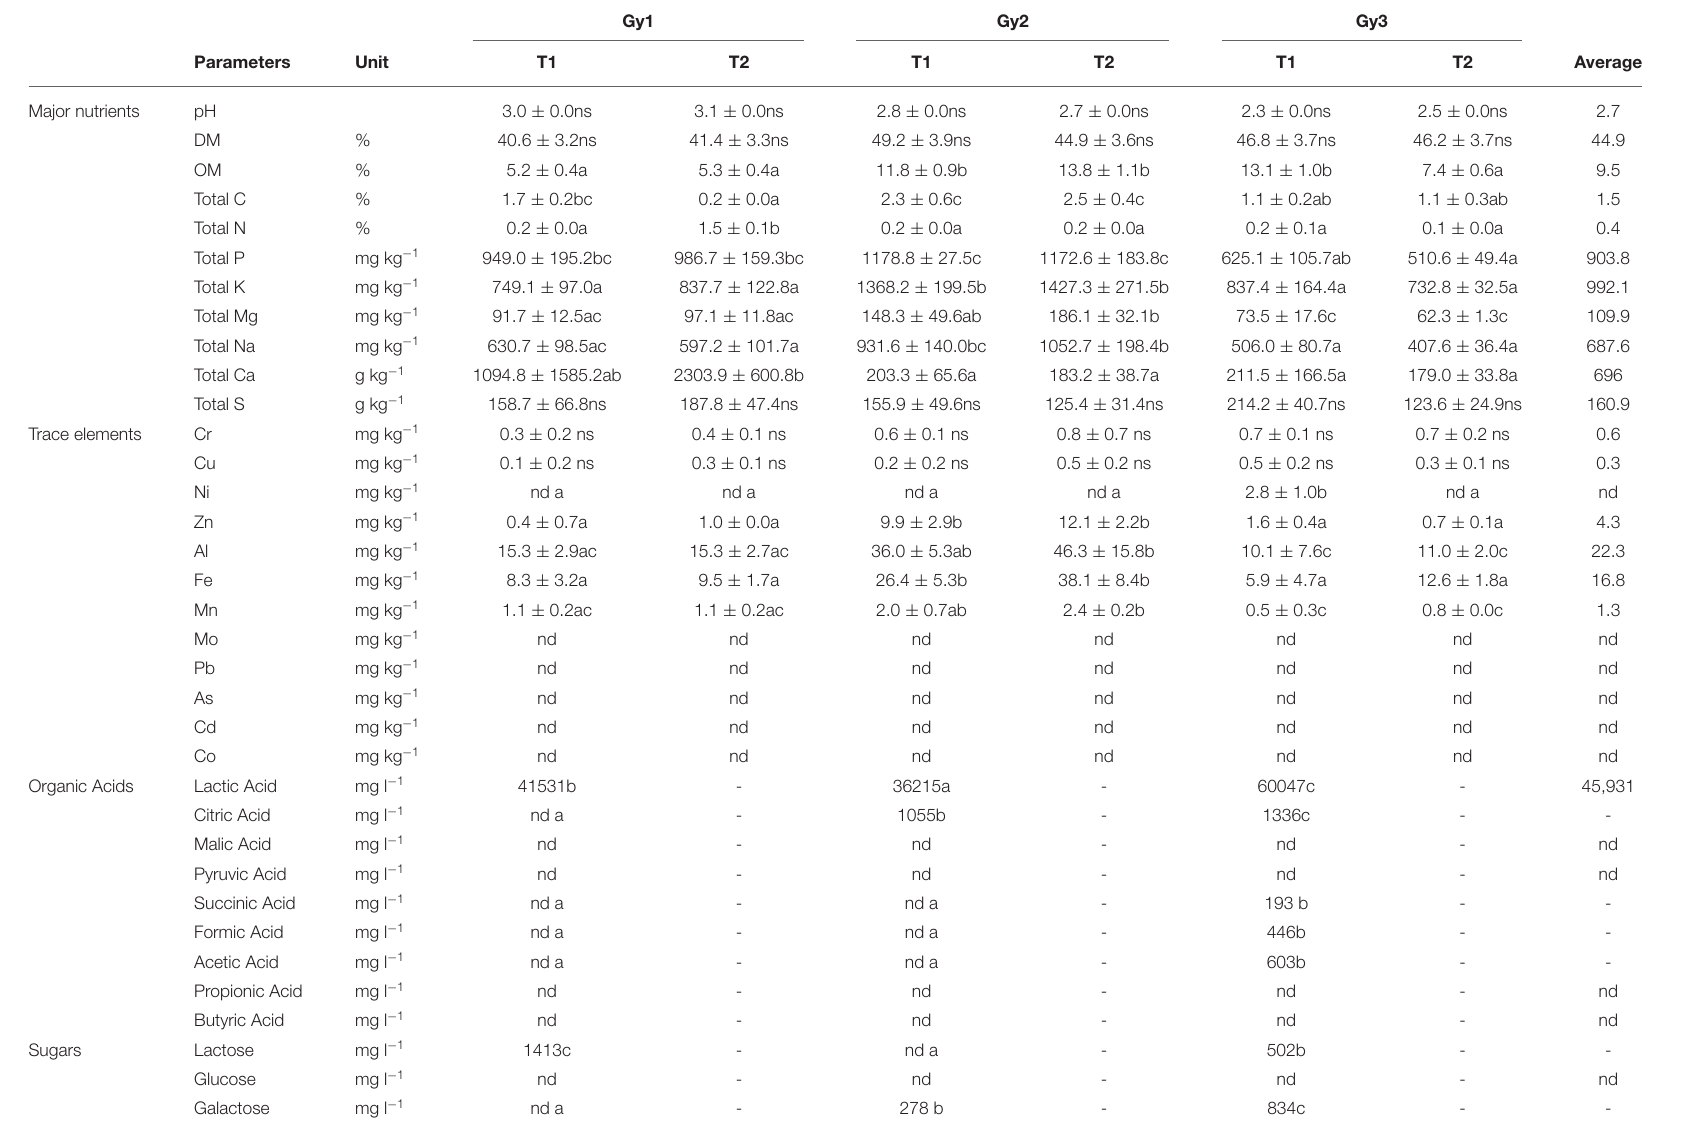
TABLE 2 | Major nutrient content, trace elements, organic acids, and sugars in